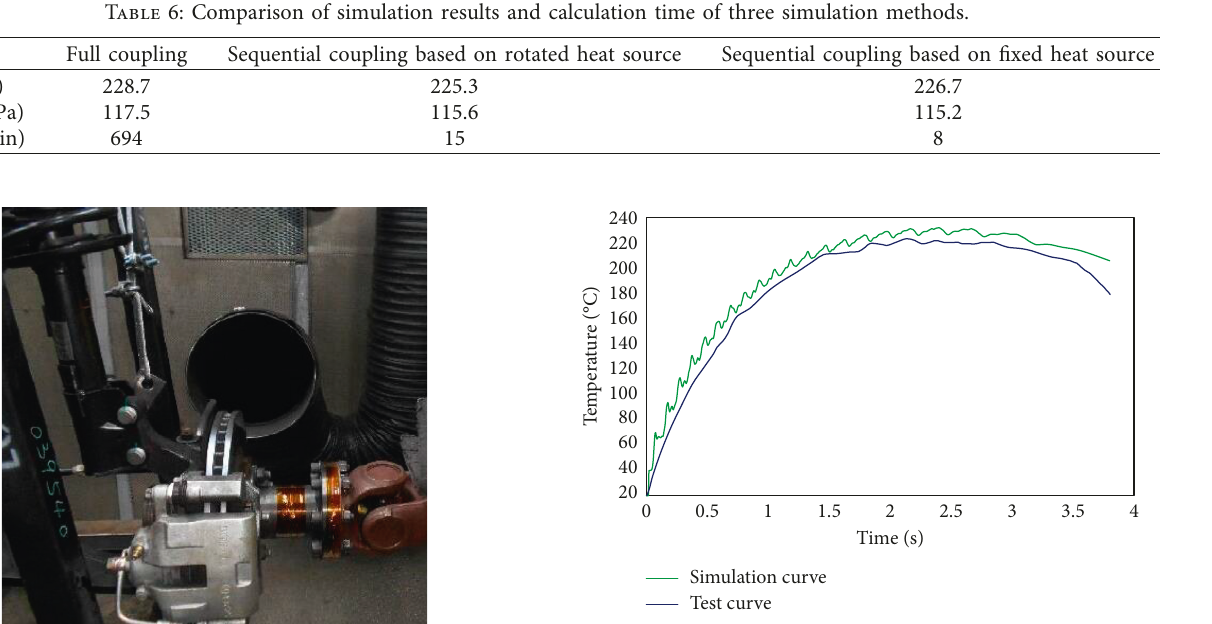
Figure 18: Comparison of test and simulation temperature curves. Table 7: Type M1 vehicle type I test requirements.